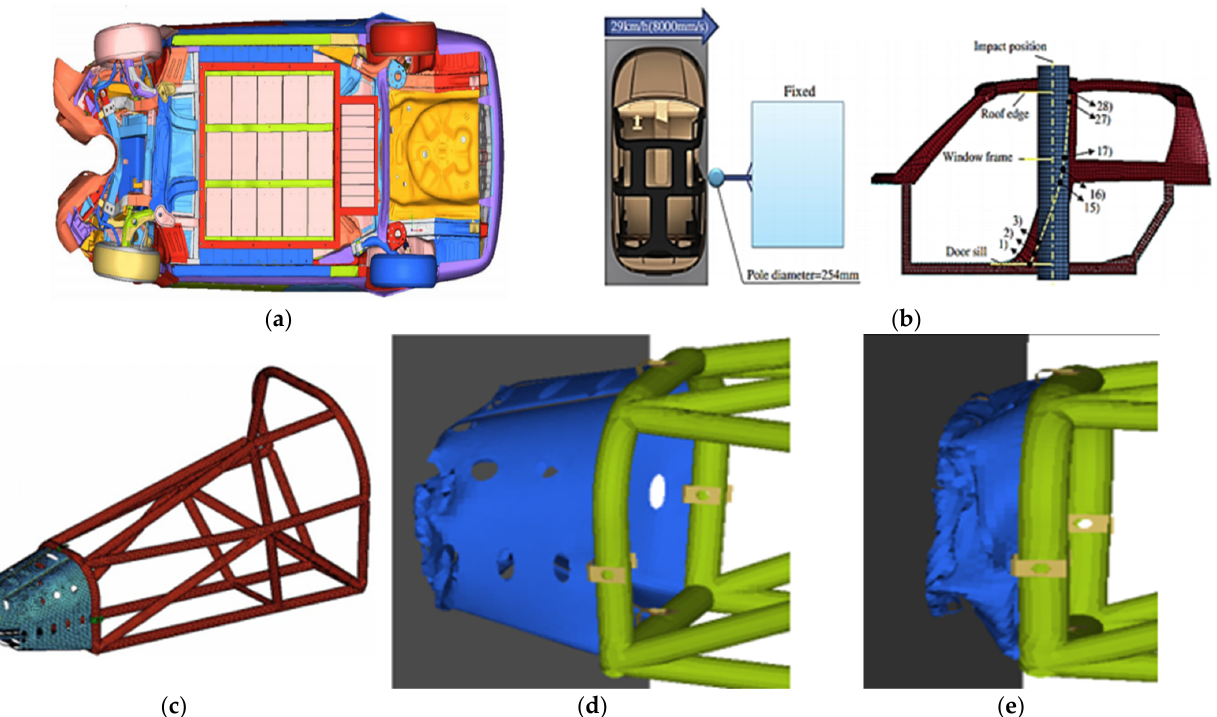
Figure 4. Examples of FEM models developed to evaluate the crashing behavior of vehicles: ( a ) the frontal pole test undertaken at 50 km/h on a rigid pole [From Navale et al. [29], with permission from Taylor & Francis]; ( b ) the side pole impact test undertaken at 29 km/h in LS-DYNA [From Liu et al. [30], with permission from Elsevier]; ( c ) the meshed impact attenuator on Hyper View; ( d ) 14 ms after crashed at 25.2 km/h; ( e ) at the end of crashing event [From Belingardi and Obradovic [74], with permission from Serbian Society for Computational